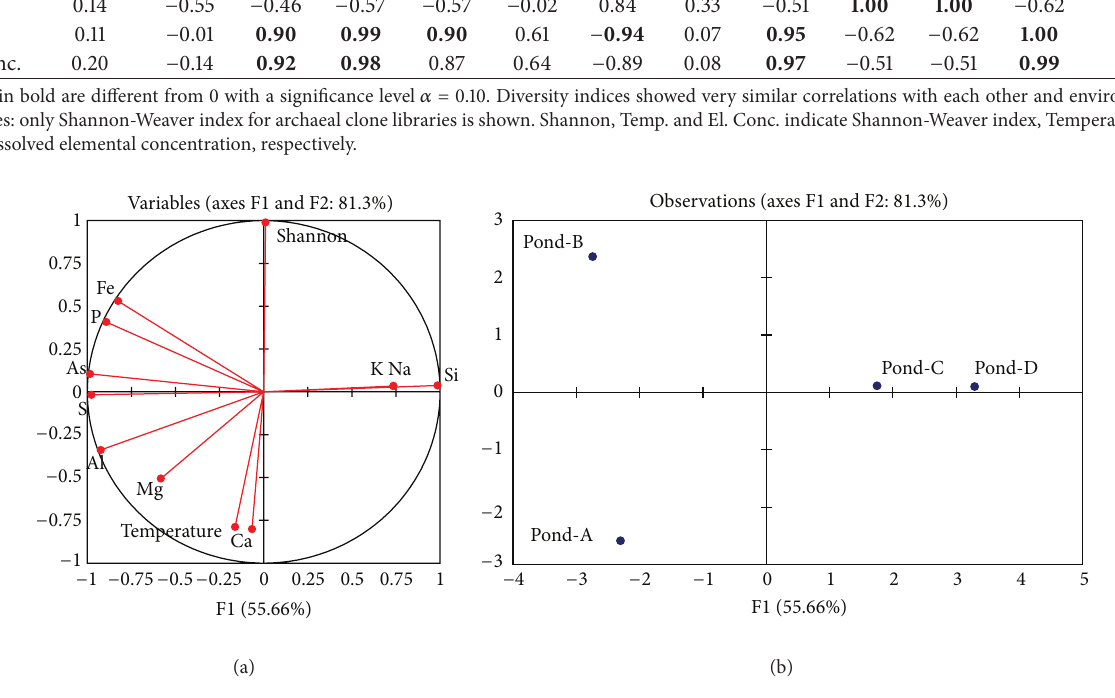
Figure 3: Principal components analysis showing loadings on principal components 1 and 2 for environmental factors at sites and the relationship to each site. Shannon, Temp. and El. Conc. indicate Shannon-Weaver index, temperature, and total dissolved elemental concentration,